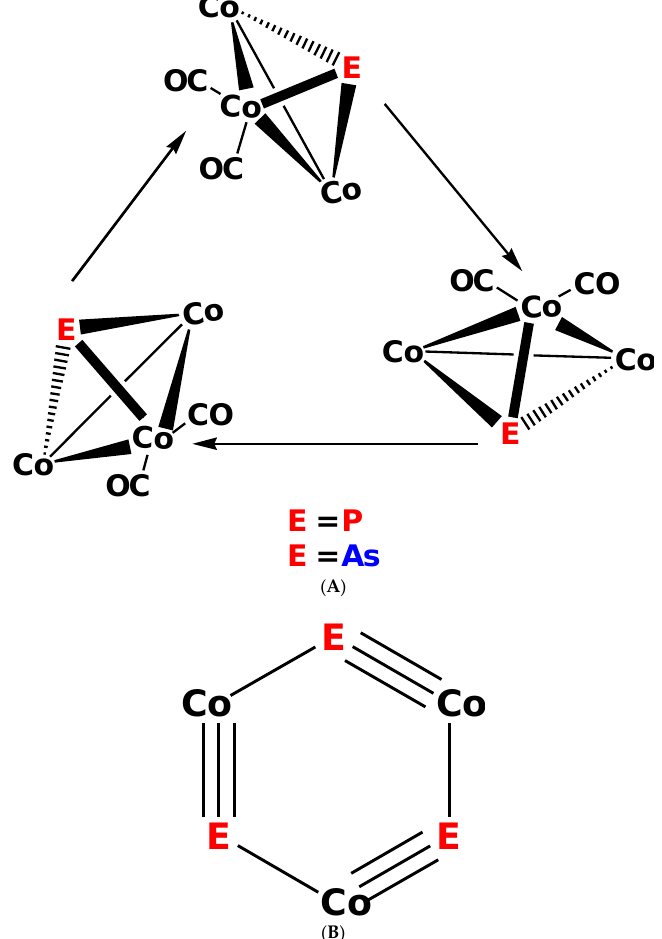
Figure 8. ( A ): Schematic view of the structure of complex 9, E = P [34] and of complex 11 , E = As